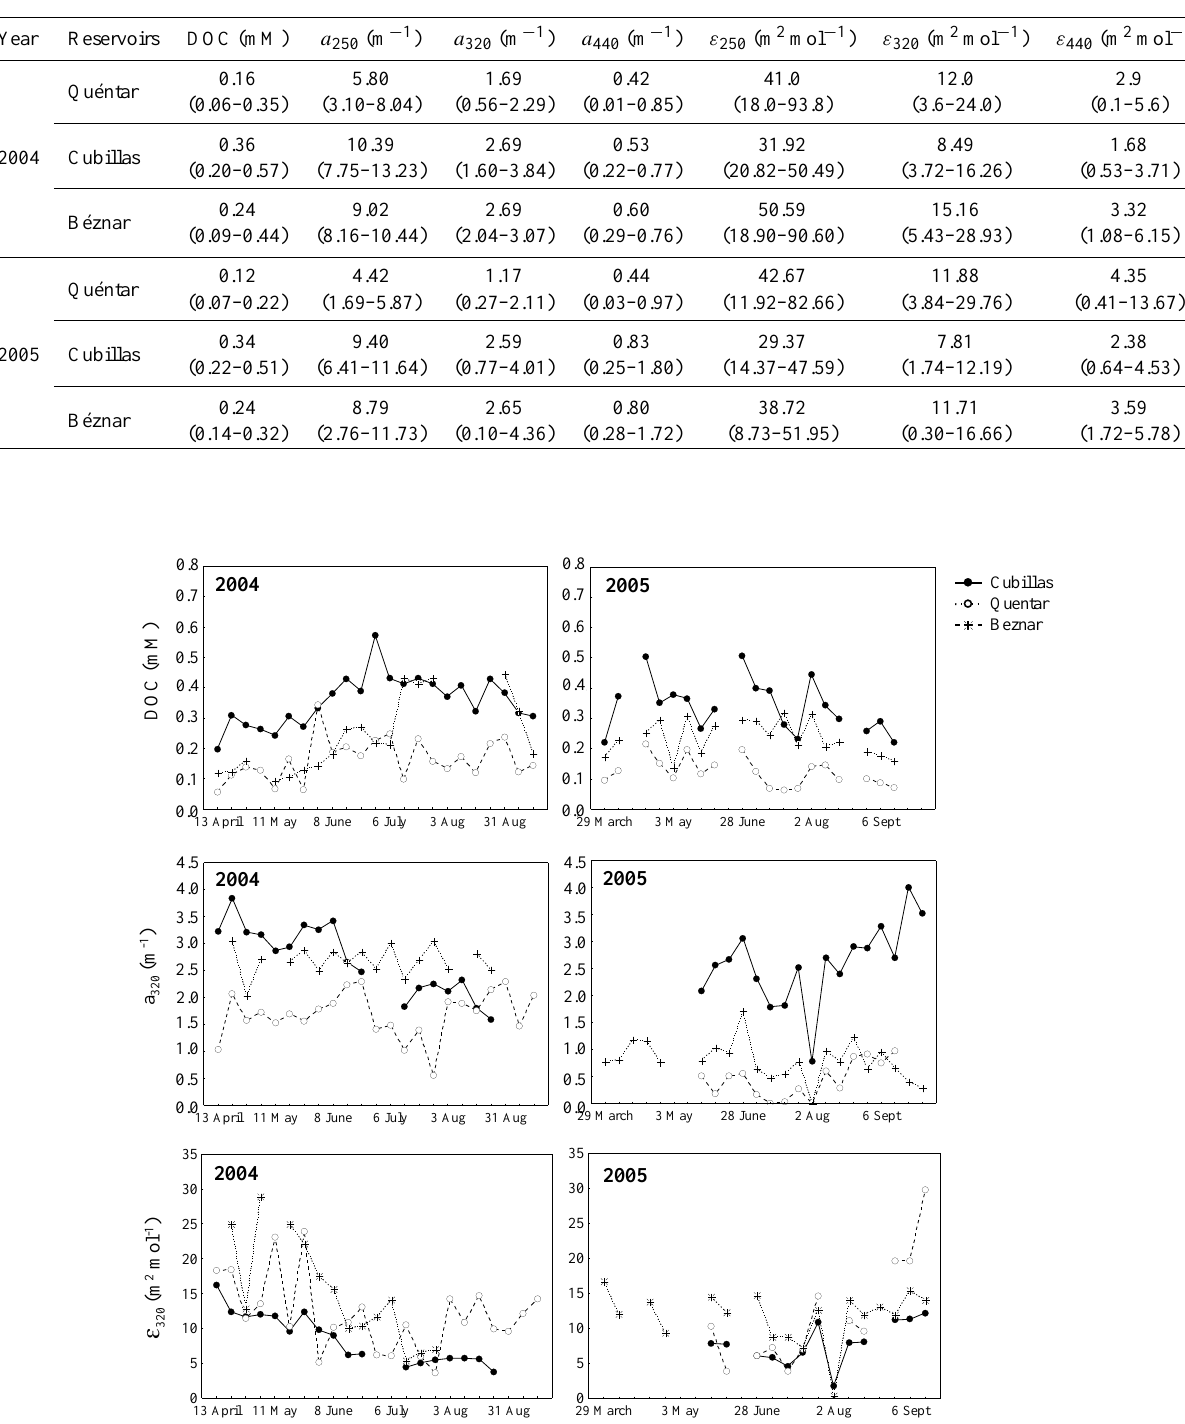
Table 4. Average values and ranges (in parentheses) of dissolved organic carbon (DOC), absorption coefficients at 250nm ( a 250 ) , 320nm ( a 320 ) , and 440nm ( a 440 ) in the study reservoirs during the stratification periods of 2004 and 2005.